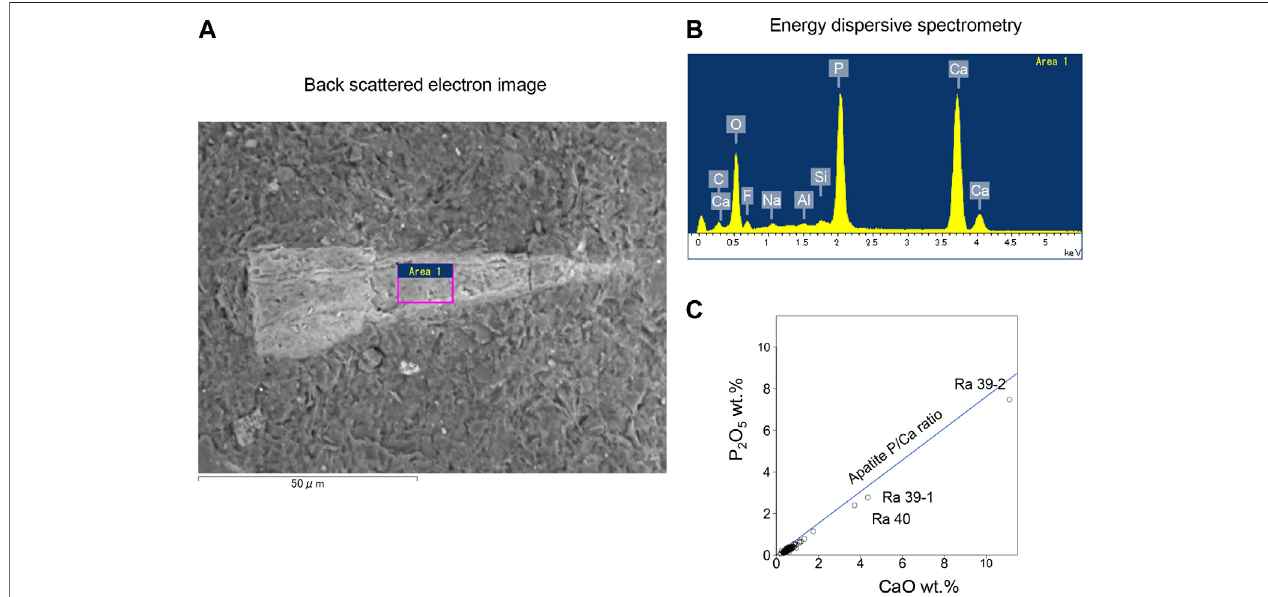
FIGURE 5 | (A) Scanning electron microscopy (SEM) image of the intercalated mudstone. Purple square indicates the region within an apatite for the Energy dispersive spectrometry (EDS) analysis. (B) Energy dispersive spectrometry of the apatite fragment. (C) Scatter plot of CaO and P 2 O 5 of the whole-rack chemical compositions. The variation of the samples is along with the apatite P/Ca